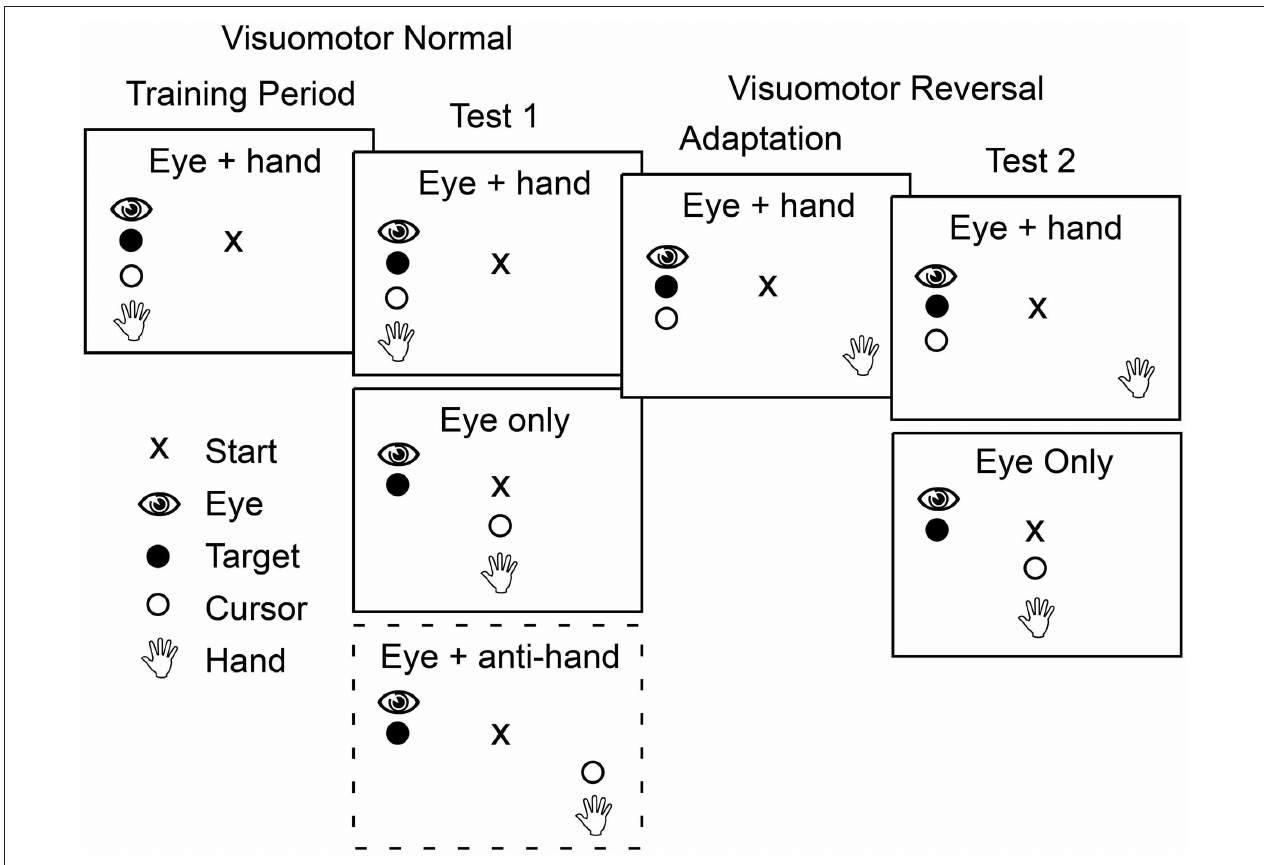
FIGURE 2 | Schematic outline of the four phases that participants completed in both Experiment 1 and Experiment 2. In the first two phases, training and test 1, the mapping between position of the hand and the cursor controlled by the hand was veridical. In contrast, in the last two phases the cursor position was rotated 180 ◦ about the start position such that a rightward hand movement produced a leftward cursor movement. During training and adaptation, participants made only